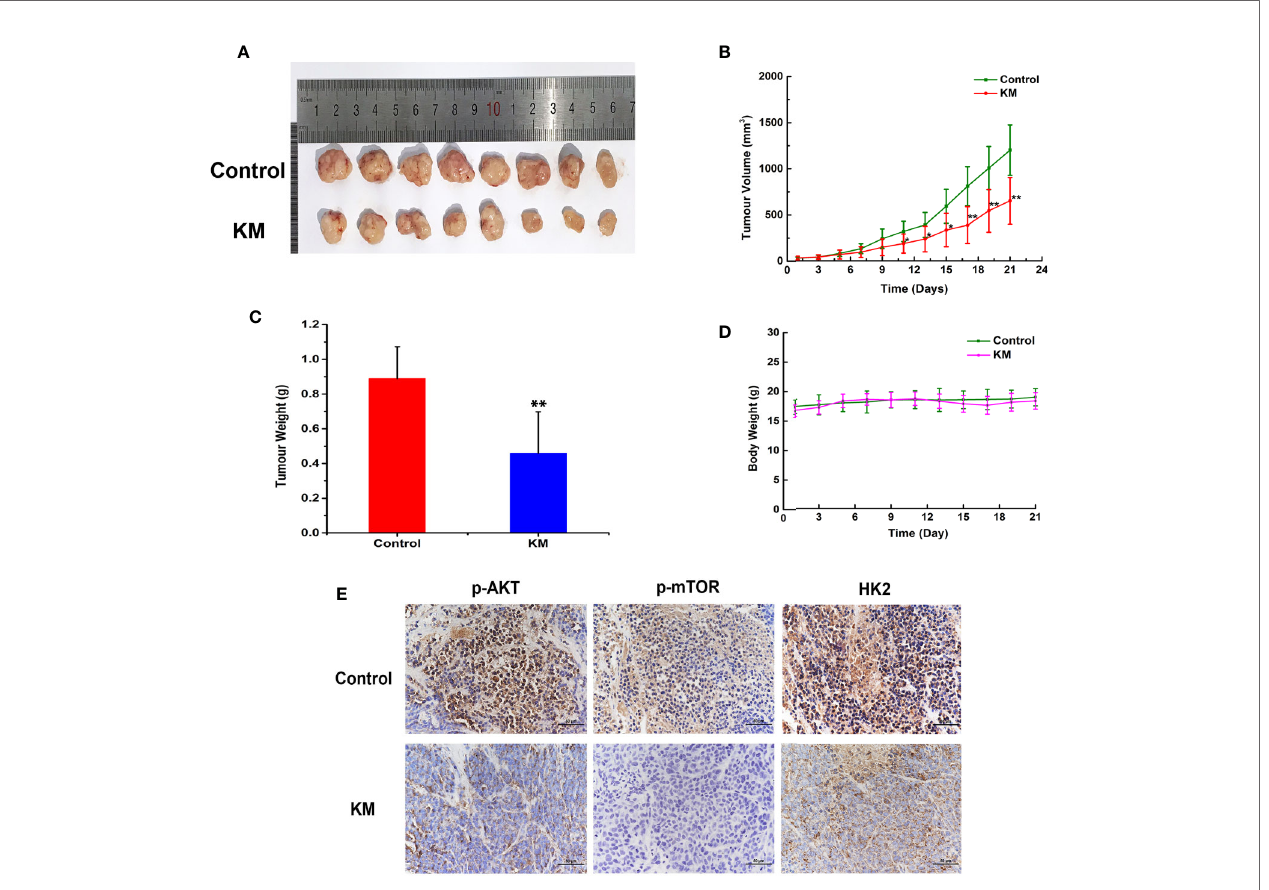
FIGURE 6 | KM inhibited colorectal tumor progression by Akt/mTOR/HK2 pathway in CRC xenograft mouse models. (A) Photograph of tumors in vehicle and KM treated group. (B) Tumor growth curve of control and KM treated group. (C) Tumor weight of control and KM treated group (D) The change of body weight of tumor bearing mice. (E) Immunohistochemical staining detection of p-Akt, p-mTOR and HK2 in tumor sections from control and KM-treated mice. All panels are of the same magni fi cation. Data were shown as mean ± SD (n = 8). signi fi cance: * P < 0.05, ** P < 0.01 vs